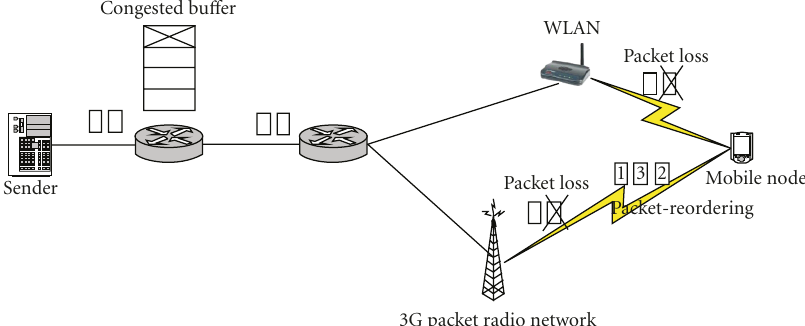
Figure 1: Three packet loss scenarios: (1) congestion losses over the wired network, (2) packet loss over WLAN, and (3) packet loss and packet reordering over 3G packet